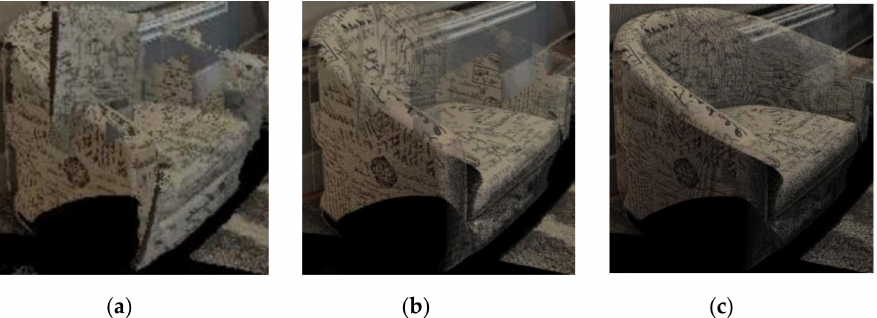
Figure 19. ( a ) Chair resolution (786, 1572); ( b ) chair resolution (3000, 6000); ( c ) chair resolution (5000,